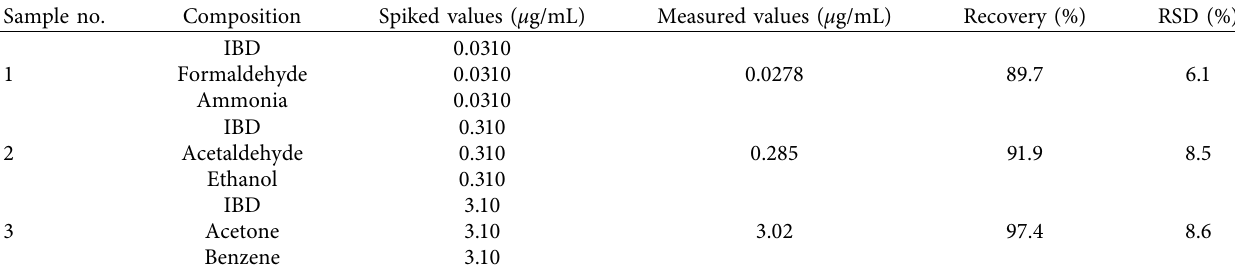
Table 1: Analysis results of IBD samples measured by the proposed CTL sensor. Sample